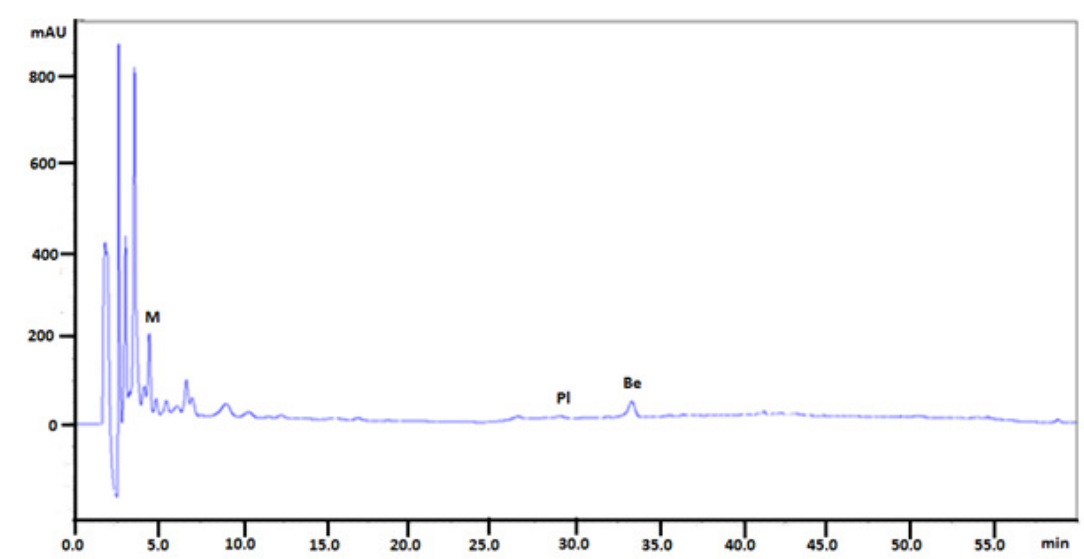
Figure 5. Chromatogram obtained for Mahonia aquifolium leaves extract obtained on Polar RP column with mobile phase MeCN, water and 1-butyl-3-methylimidazolium tetrafluoroborate. Abbreviations: Pl—palmatine, Be—berberine, M—magnoflorine. Plant material was collected during flowering.